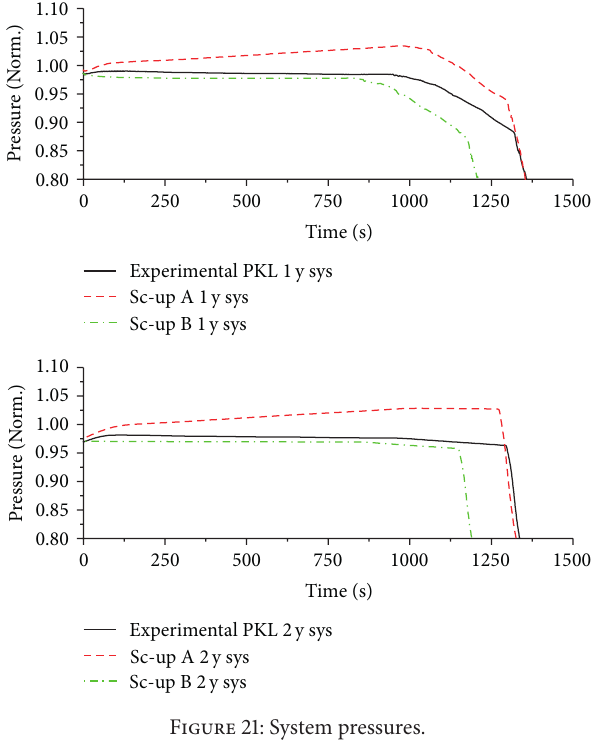
Figure 21: System